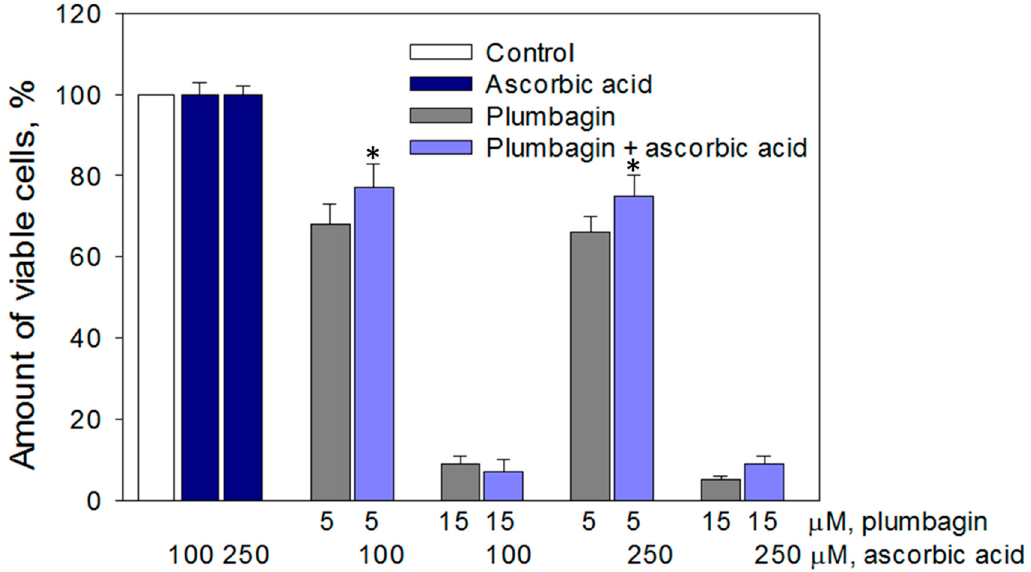
Figure 4. E ff ects of di ff erent concentrations of plumbagin and ascorbate on the viability of C6 cells. C6 cells were treated with 5 µ M and 15 µ M concentrations of plumbagin and 100 µ M and 250 µ M of ascorbate for 24 h. Cell viability was assessed using the MTT method (for details, see the Materials and Methods). Data are presented as means of the percentage of the untreated control cells ± SE ( n = 3). * p < 0.05 versus